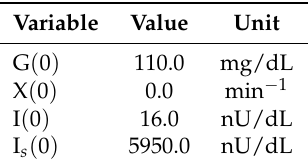
Table 4. Initial condition determined for the control group at PND21. These initial conditions are conserved for groups Cd1 and Cd2. Note that 1 U = 0.0347 mg of insulin.